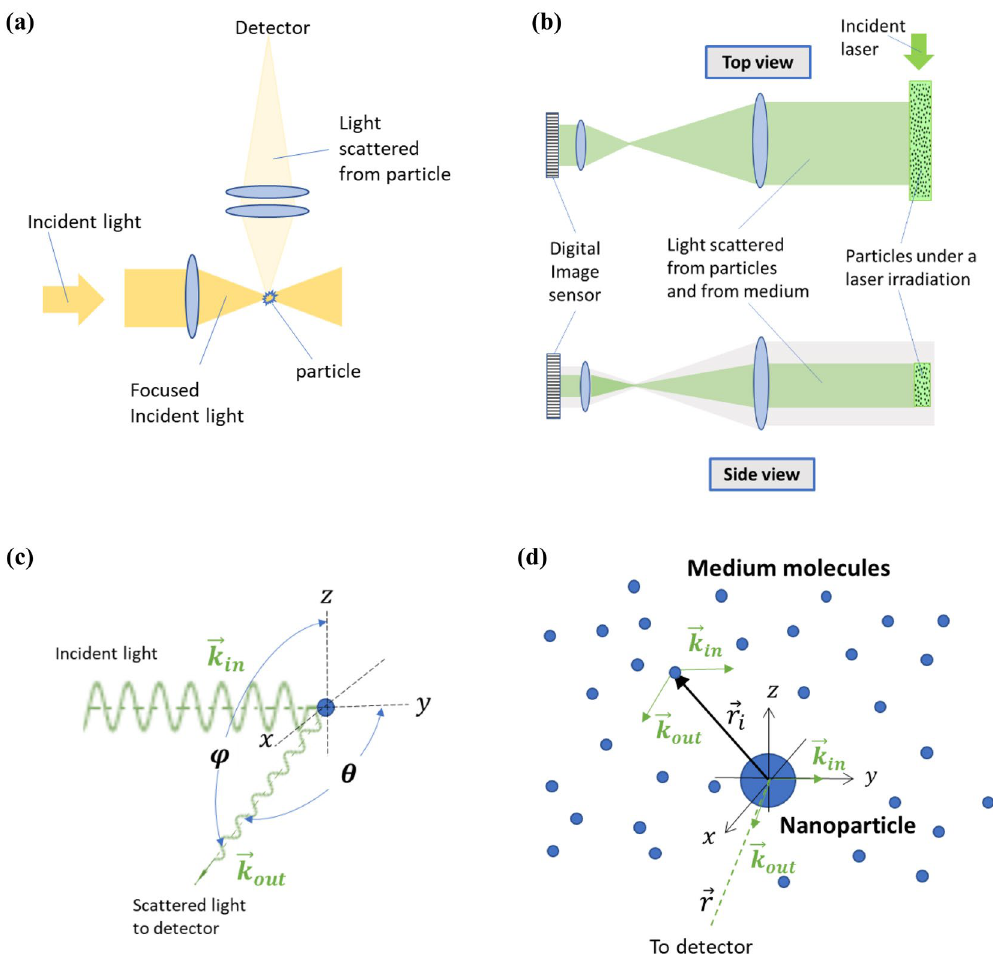
Figure 1. Optical diagrams and vectors of incident light and scattered light. ( a ) An optical diagram for the method derived from the development of ultramicroscopes in the early twentieth century 4 , which is a dark field approach with condenser and objective lenses to observe or detect a particle in the optical focus. This approach continues to be the basic mechanism of many advanced optical microscopes and laser particle counters used today. ( b ) An optical diagram for the proposed method to detect suspended nanoparticles contained in a large container utilizing medium light scattering. Image of light scattering by the nanoparticles and by the